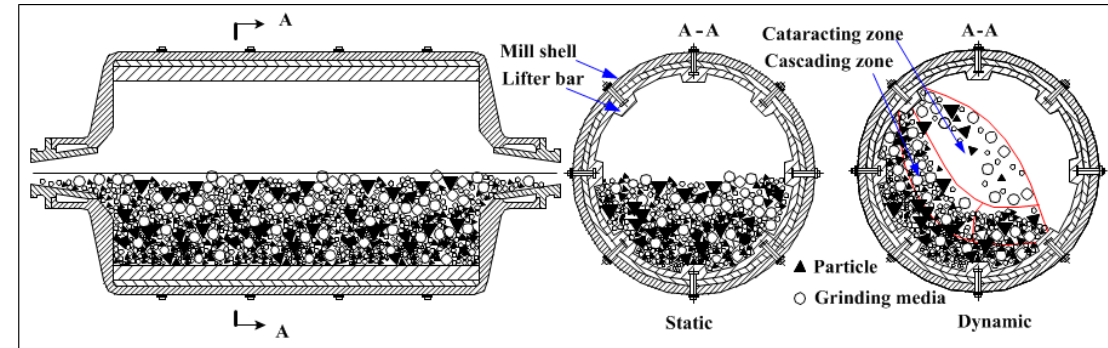
Figure 1. Schematic diagram of ball mill.